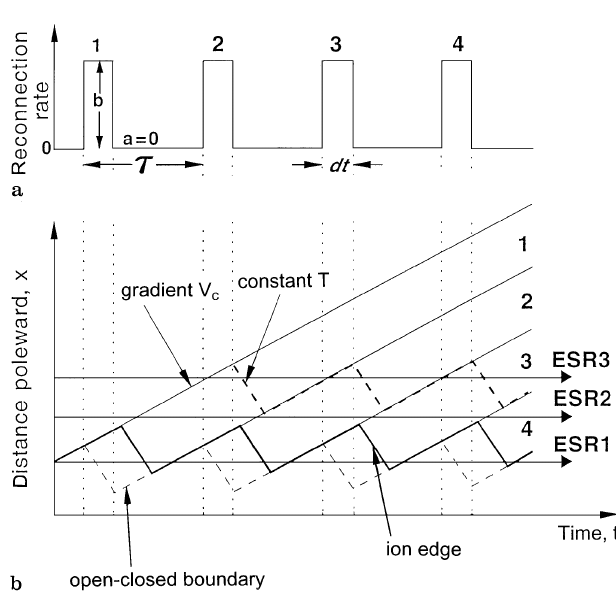
Fig. 1. a Reconnection-rate variation showing square wave pulse, labelled 1 — 4, dt long and of repeat period (cid:113) . The rate within the pulses is b , that between the pulses, a , is here zero. b Distance of field lines, along the magnetic meridian, x , as a function t . The boundaries between patches 1 — 4 (opened by pulses 1 — 4) move polewards with the constant poleward convection speed, » (cid:99) . Three lines of constant time elapsed since reconnection are shown: the thin dashed line is „" 0 (i.e. the o/c boundary); the thick solid line is „+ 120 s (i.e. the ion edge); and the thick dashed line is the „ at which precipitation flux decays to below the threshold which defines it as cusp (i.e. the poleward edge of the cusp). The mean latitude of the o/c boundary is taken to be constant. The horizontal lines marked ESR1, ESR2 and ESR3 show the locus of the radar for the locations, relative to the mean o/c boundary, which give rise to the variations shown in Fig. 6a, b and c,